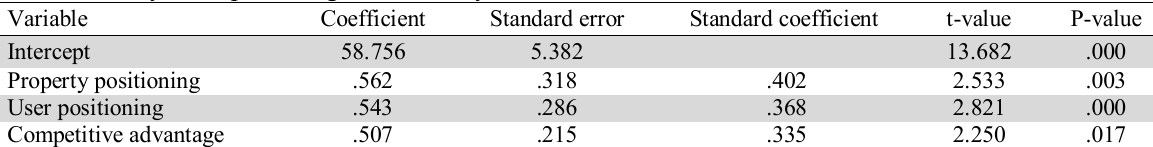
The summary of stepwise regression